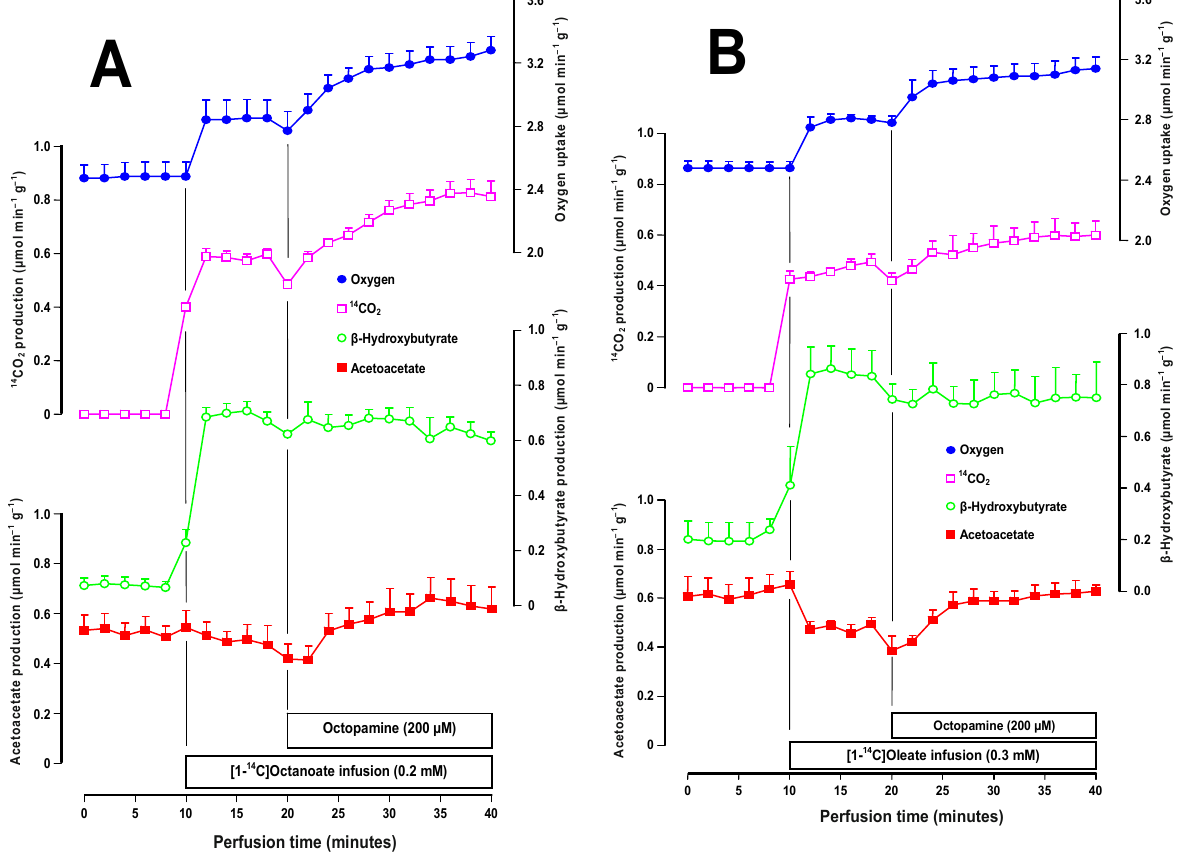
Figure 3. Effects of octopamine on medium- and long-chain fatty acid metabolism. Livers of fasted rats were perfused as described in the experimental section. Panel A illustrates the time courses of the changes caused by 200 μ M octopamine during 0.2 mM [1- 14 C]octanoate infusion and Panel B the time courses of the changes caused by 200 μ M octopamine during 0.3 mM [1- 14 C]oleate infusion. [1- 14 C]oleate was dissolved into the Krebs/Henseleit-bicarbonate buffer containing 0.15 mM fatty acid-free bovine-serum albumin. Datum points are means ± mean standard errors of 3–4 liver perfusion